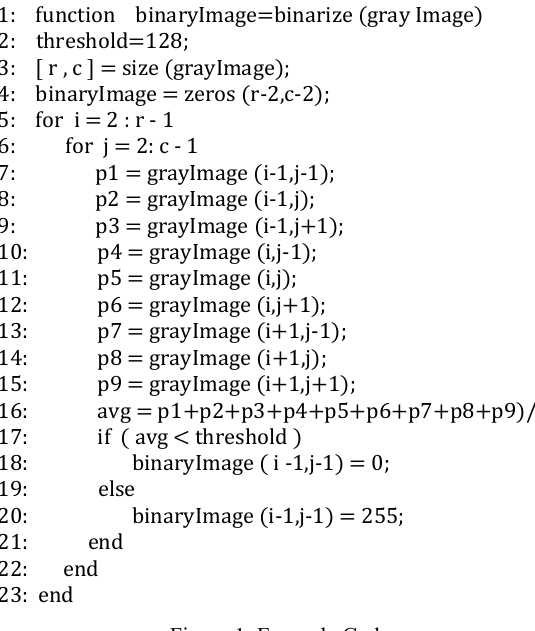
Figure 1 Example